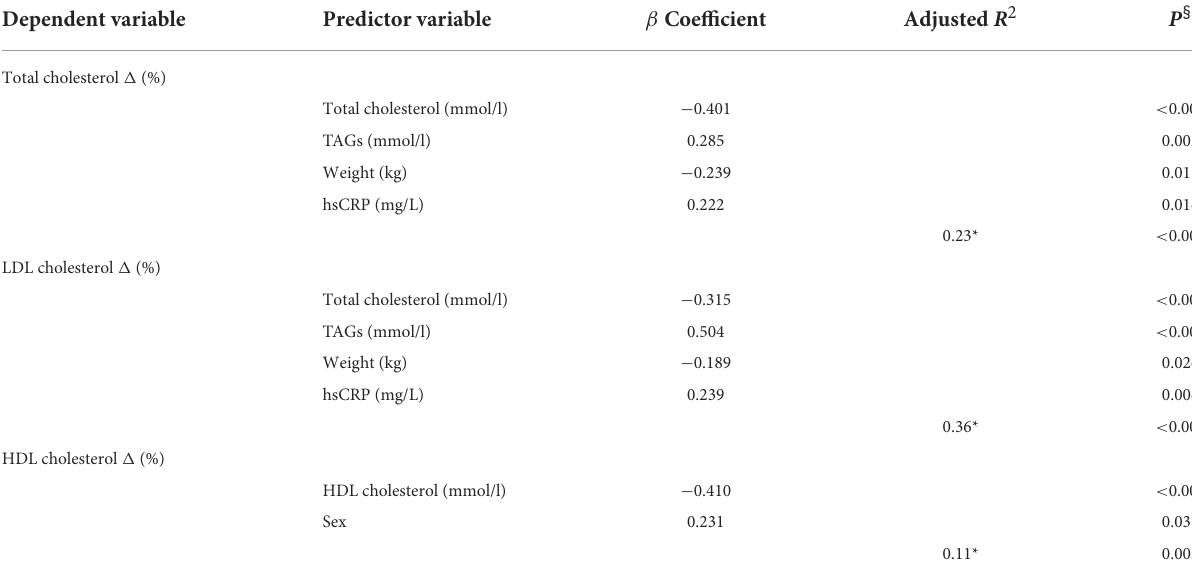
TABLE 4 Predictors of total, LDL and HDL cholesterol 1 (%).